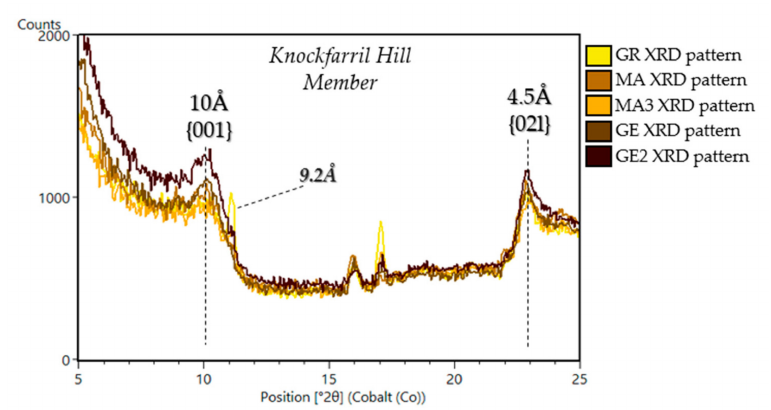
Figure 17. CheMin XRD patterns of samples from the Knockfarril Hill member. The position of the d(001) and d(02l) peaks are denoted by dashed black lines. A pronounced 10 Å peak is seen in the all patterns and peaks at ~9.22 Å and 11.1 Å are observed in the GR pattern, and the GR sample is the topic of an upcoming special edition publication on GT.